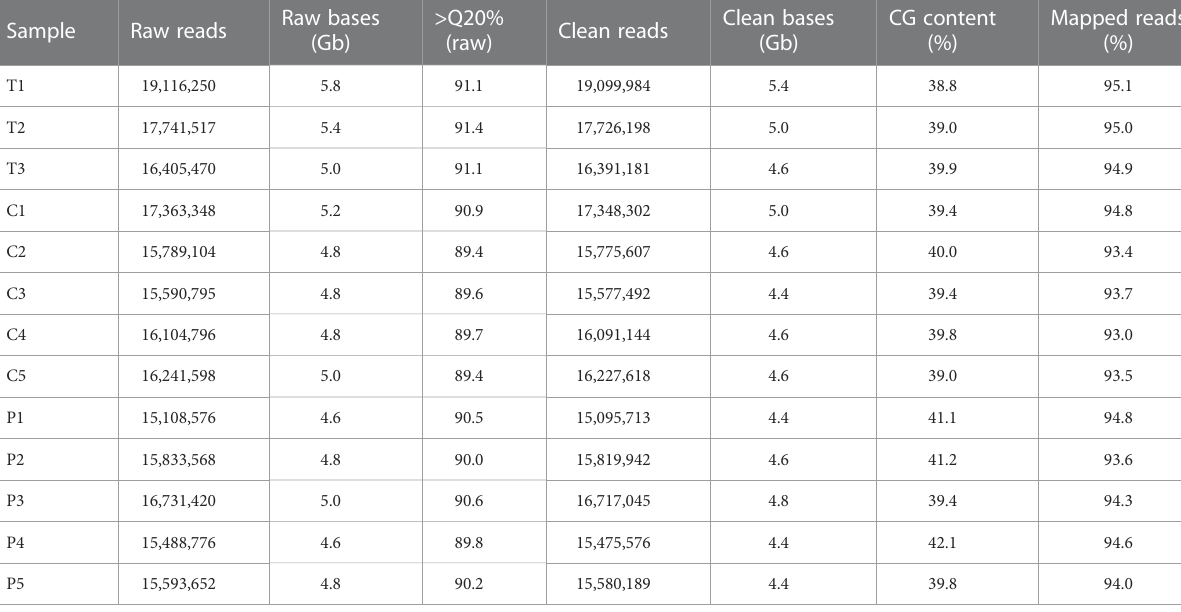
TABLE 3 Summary of transcriptome data of ANG during female maturation.